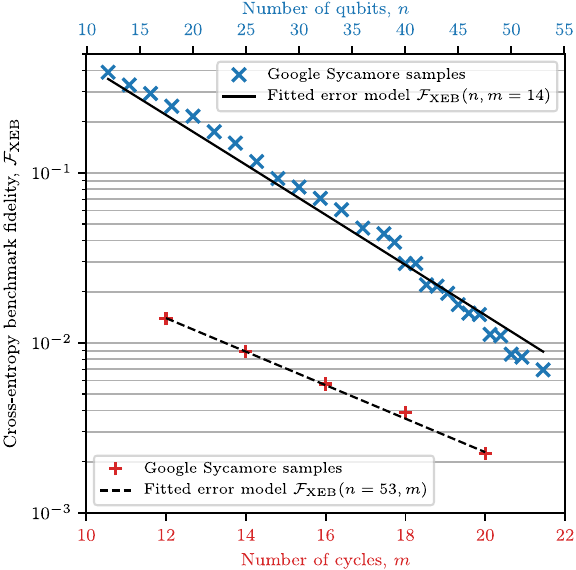
Fig. 5 Empirical fi delity model Eq. (2) for λ = 0.0043 ± 0.0008 and γ = 0.042 ± 0.017 (to two standard deviations) showing quality of fi t for elided veri fi able circuits of fi xed depth (blue) and elided supremacy circuits of fi xed width (red). The deviation from the fi t